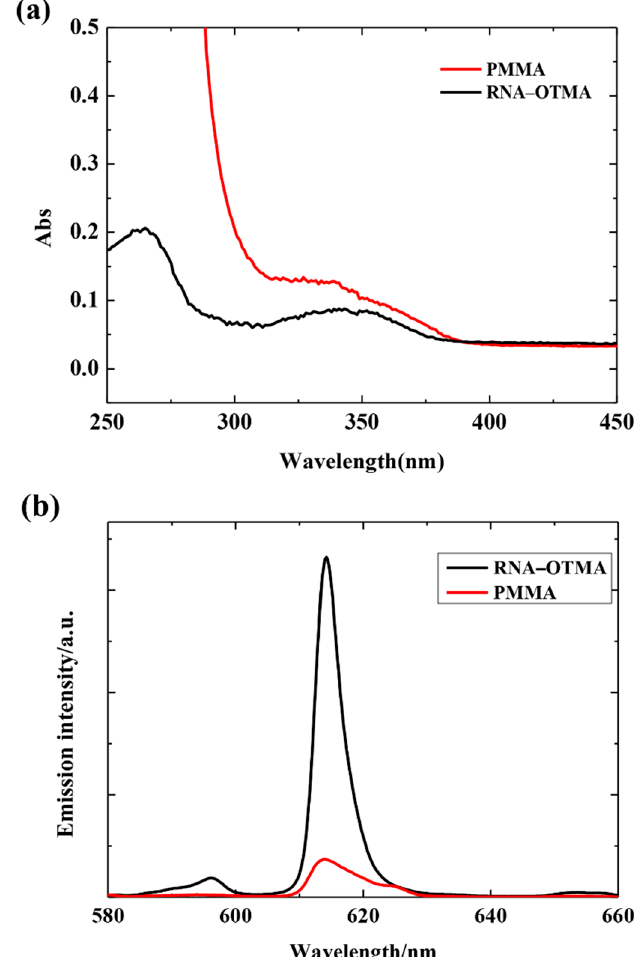
Figure 8. ( a ) UV absorption spectra of PMMA/Eu (TTA) 3 (H 2 O) 2 and RNA–OTMA/Eu (TTA) 3 (H 2 O) 2 in butanol solution and ( b ) fluorescence emission spectra of the films.